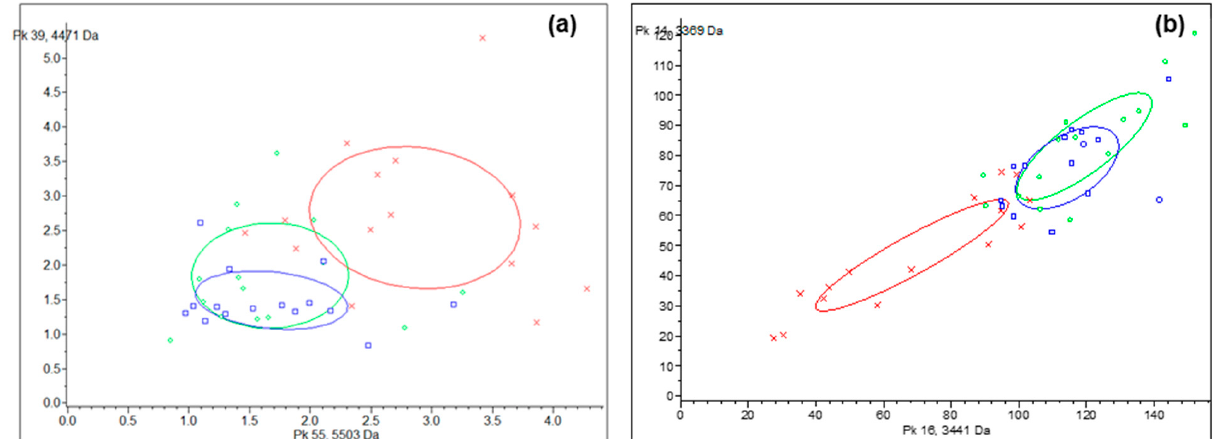
Figure 3. Scatter plot of the saliva samples ( a ) established by the combination of peptide/protein with m/z 5502.59 (x-axis) and 4471.34 (y-axis) and GCF samples ( b ) established by the combination of peptide/protein 3440.58 and 3369.34 m/z served as the x- and y-axes, respectively, between patients with oral health (red) and FOA (green) and IN (blue) patients. The discriminating attributes of the first two peaks from the list of p values. Ellipses correspond to 95% confidence